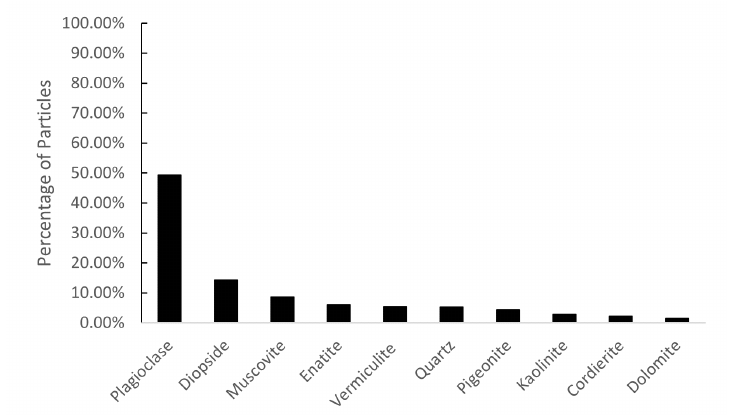
Figure 8. Sediment mineral composition.